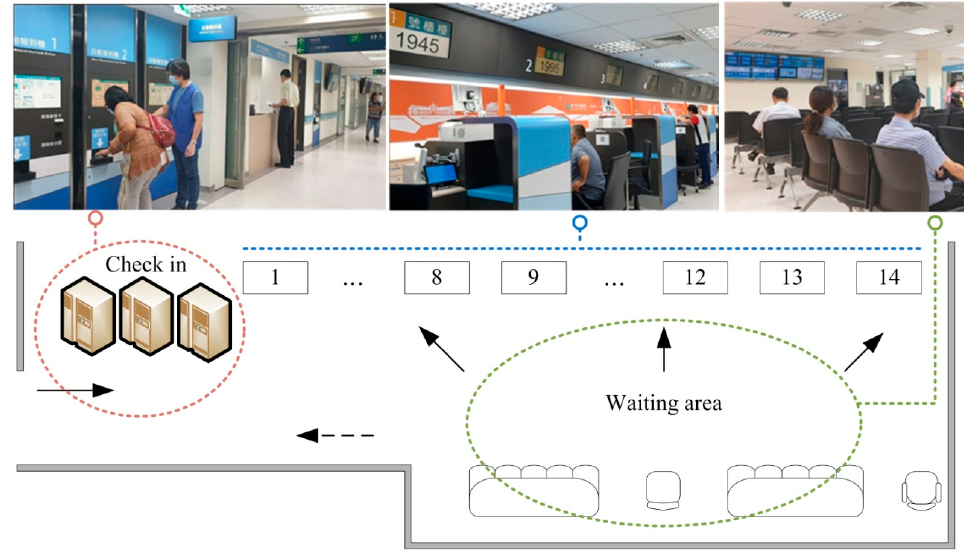
Figure 2. The phlebotomy service area and patient flow. Blood drawing counters 1–12 were for general subjects and 1–8 were priority counters for elderly subjects, while counters 13 and 14 were for wheelchair users. Age ≥ 80 years was defined as elderly from 1 November 2018 (phase 1), while age ≥ 78 years was defined as elderly from 1 July 2019 (phase 2). The area of the waiting area was about 62.4 m 2 . Solid arrow: the subjects arriving; Dotted arrow: the subjects